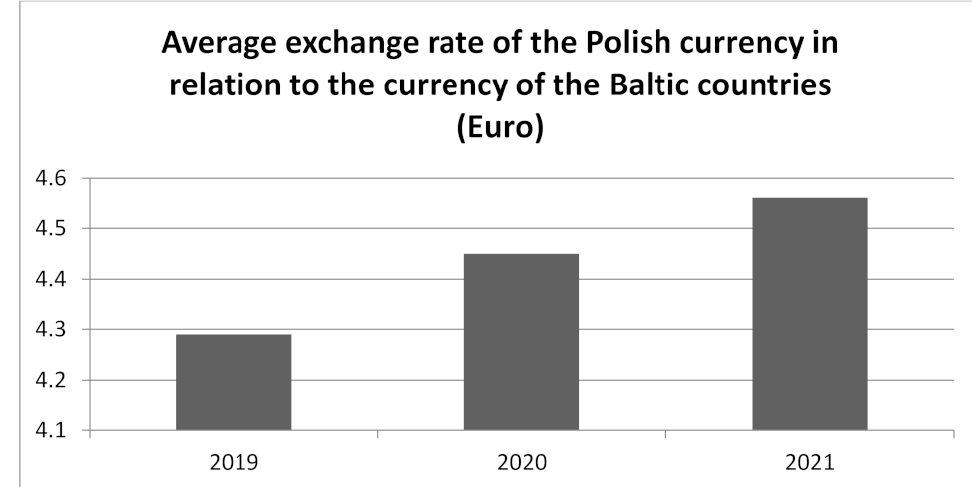
Figure 6. The change average exchange rate of the Polish currency (PLN) against the currency of the Baltic countries (Euro) in the period 1 December 2019–1 September 2021